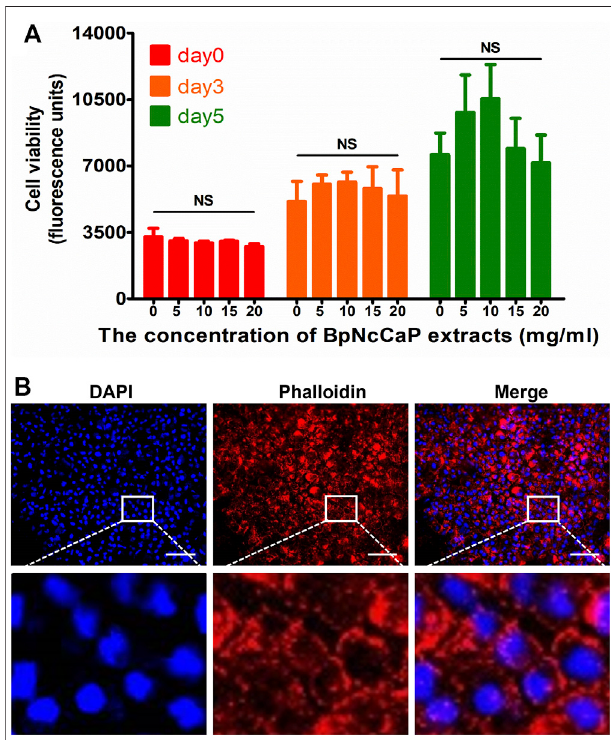
FIGURE 6 | Graph depicting the metabolic activity of MC3T3-E1 exposed to the different concentrations of BpNcCaP extracts using a PrestoBlue assay (A) . Fluorescent micrographs showing the nuclei (blue) and actin fi laments (red) of MC3T3-E1 pre-osteoblasts cultured on BpNcCaP discs (B) . The cells were cultured for 3 days and then fi xed and stained with rhodamine-phalloidin and DAPI. Bar = 100 μ